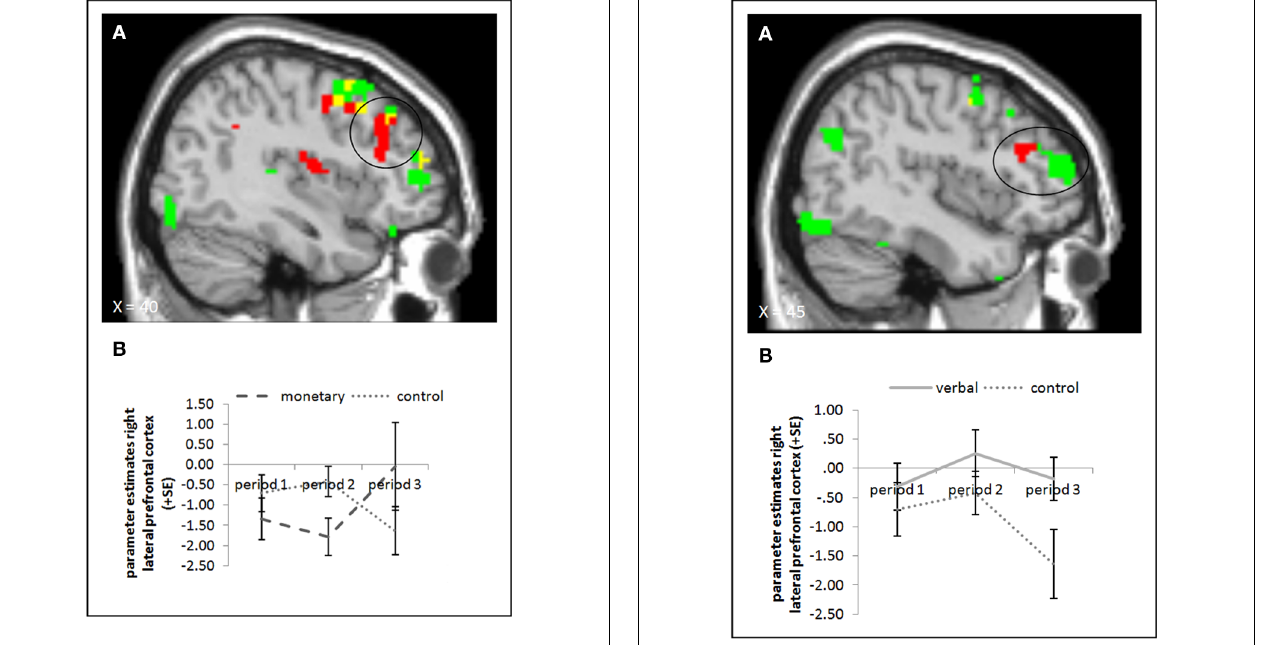
FIGURE 6 | (A) Activation for picture presentation was significantly higher in the right lateral prefrontal cortex in the verbal reward group compared to the control group in period 3 (whole brain uncorrected, p < 0 . 001, only clusters with a minimum of 10 activated voxels are shown). Activation clusters without baseline correction are shown in green, clusters with baseline correction are shown in red, activation overlaps are shown in yellow. (B) Parameter estimates are displayed for